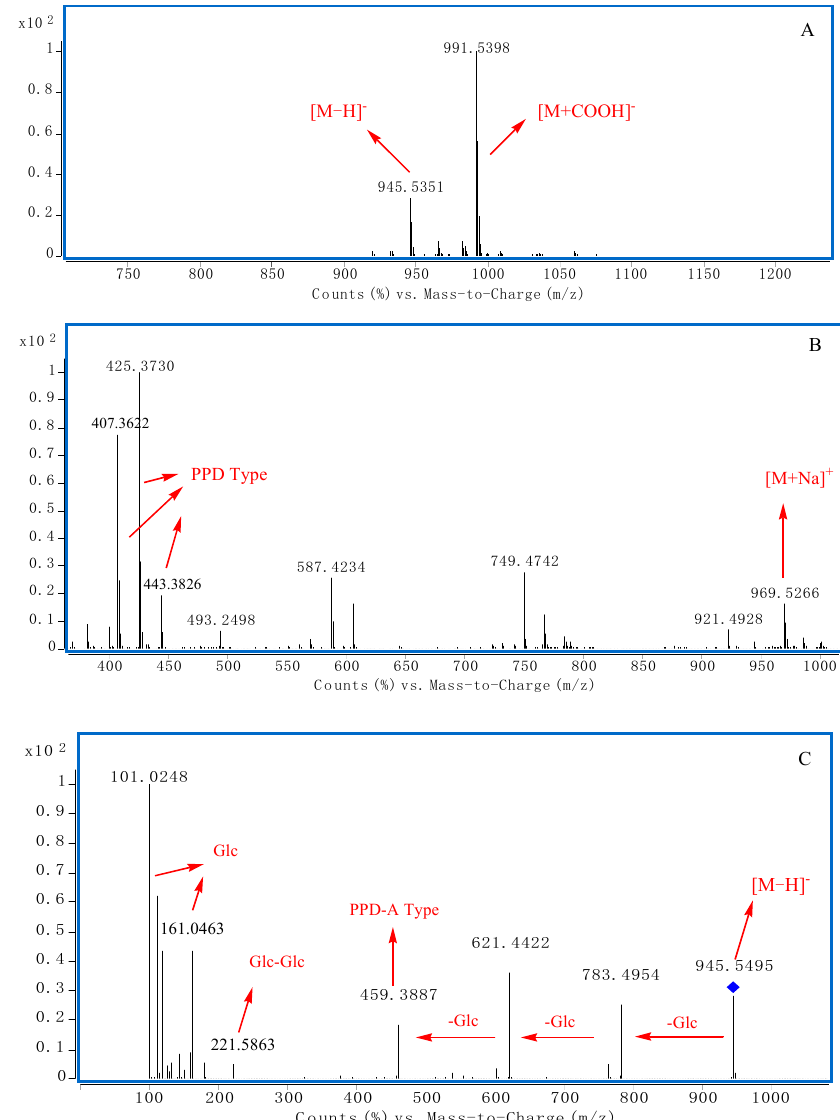
Figure 3. The typical TOF-MS spectra and fragmentation pathways of compound 91 . ( A ) MS spectrum in negative mode; ( B ) MS spectrum in positive mode; ( C ) MS/MS spectrum in negative mode.